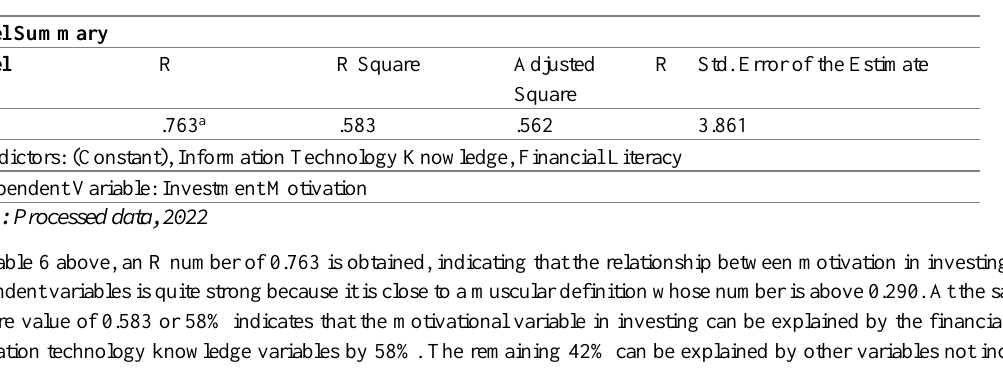
Table 6. Test Results, Coefficient of